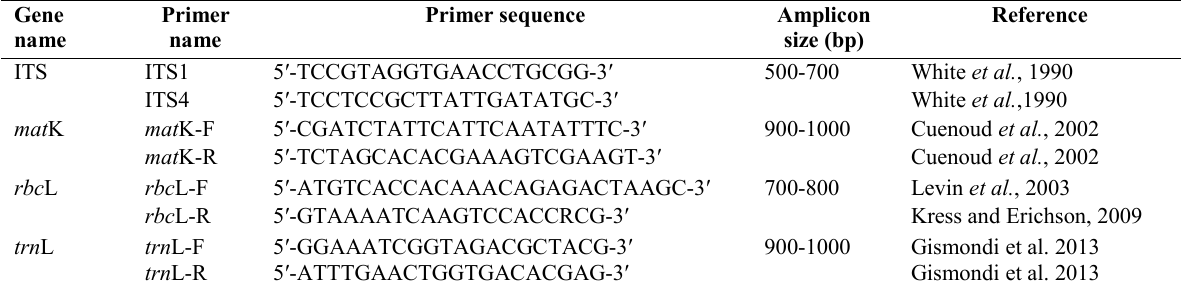
Table 2. Characteristics of primers